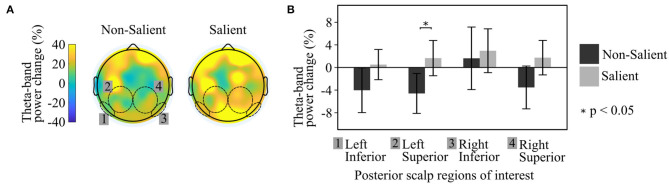
Grand Average Scalp Maps of theta (4–7 Hz) ERD/ERS when participants observed the buildings inside the VR environment. Comparison of Salient vs. non-Salient buildings. (A) Scalp map theta power change compared to baseline. (B) Statistical comparison in the four posterior scalp regions of interest.